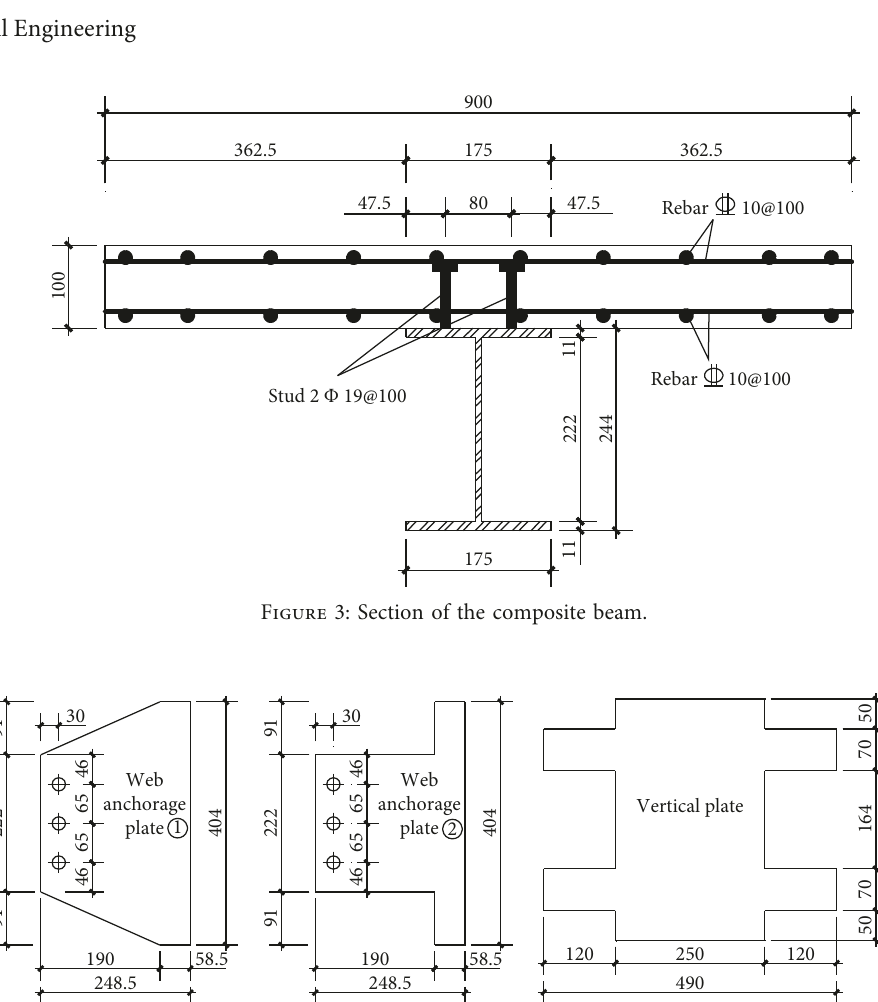
Figure 4: Details of the web anchorage plates and vertical